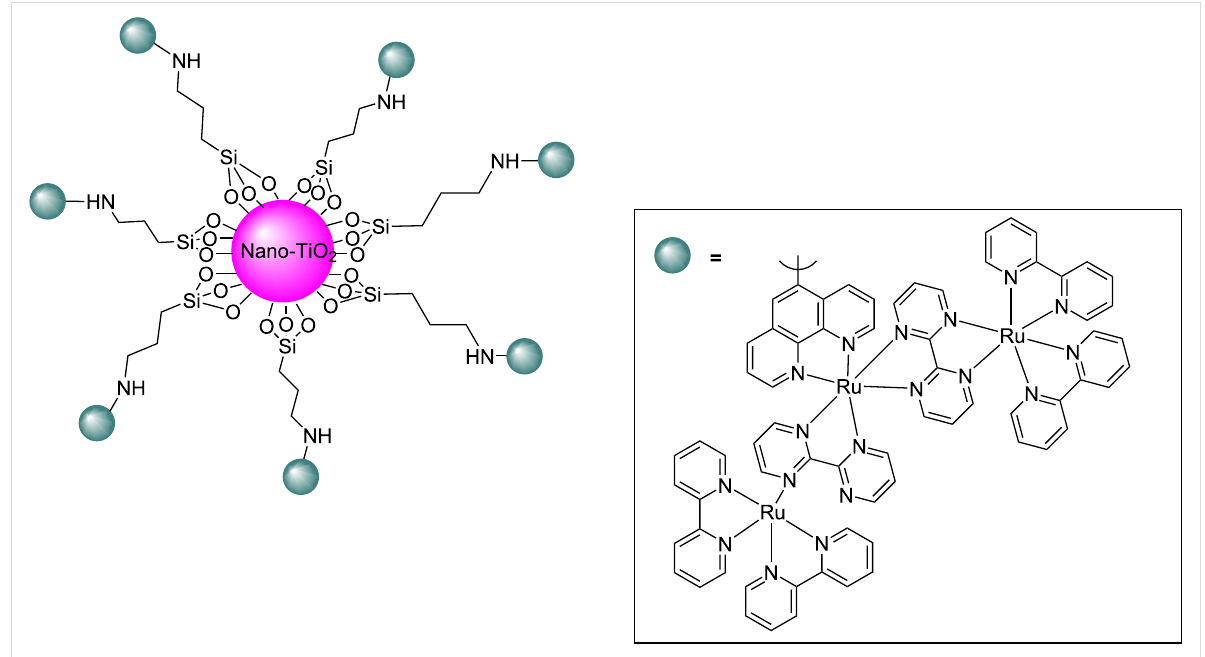
Figure 1: Structure of the TiO 2 -immobilized ruthenium polyazine